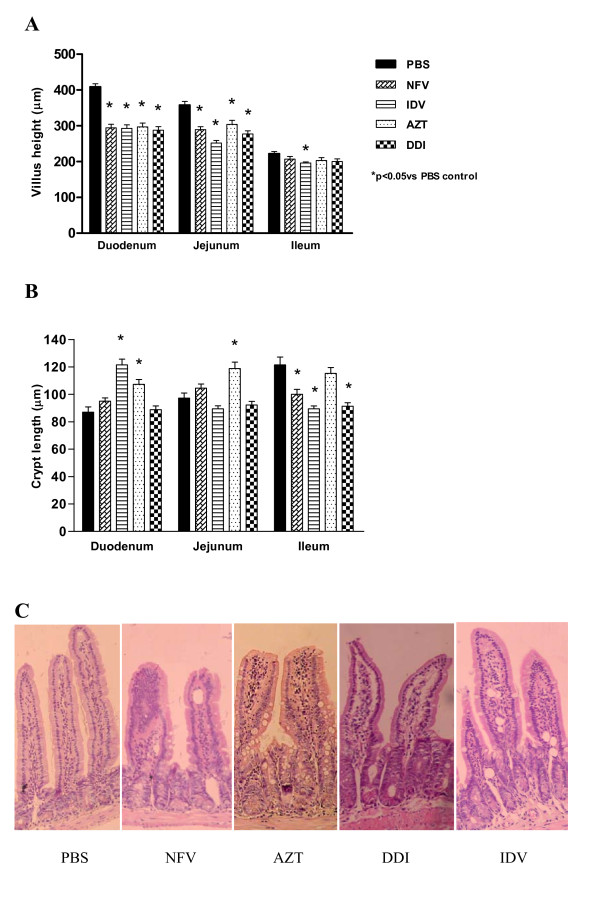
Villus height (A) and crypt depth (B) after 7 days of treatment with either nelfinavir (NFV, 100 mg/kg), indinavir (IDV, 100 mg/kg), zidovudine (AZT, 50 mg/kg) and didanosine (DDI, 100 mg/kg) or PBS. For each animal, a total of 10 villi and 10 crypts were measured for each segment of duodenum, jejunum, and ileum with a micrometer. The results are expressed as mean ± SEM of six mice per group. *statistical significance (P < 0.05) compared to the PBS control group by ANOVA, Bonferroni's multiple test. (C) Illustrative pictures of the effects of CONTROL (PBS), NFV (100 mg/kg), DDI (100 mg/kg), IDV (100 mg/kg), AZT (50 mg/kg) on the intestinal jejunal tissue, showing decreased villi length caused by all antiretrovirals and increased crypt depth caused by AZT.